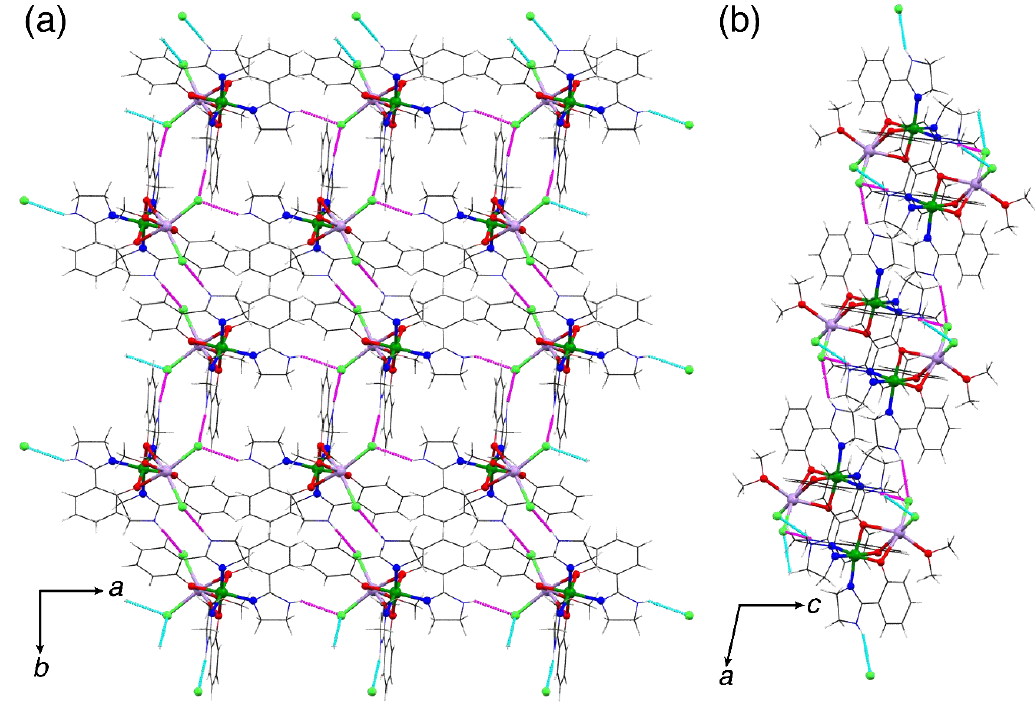
Figure 2. Hydrogen-bonded sheet structure of [Mn{Co( µ -Himn) 3 }Cl 2 (CH 3 OH)] in the ab plane. Views along the ( a ) c axis and ( b ) b axis.